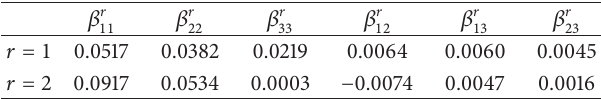
Table1:Co-regionalizationmodelcoefficientsusedinthestructural analysis of the transformed variables 𝑍 ∗ 𝑗 , 𝑗 = 1, 2, 3 .